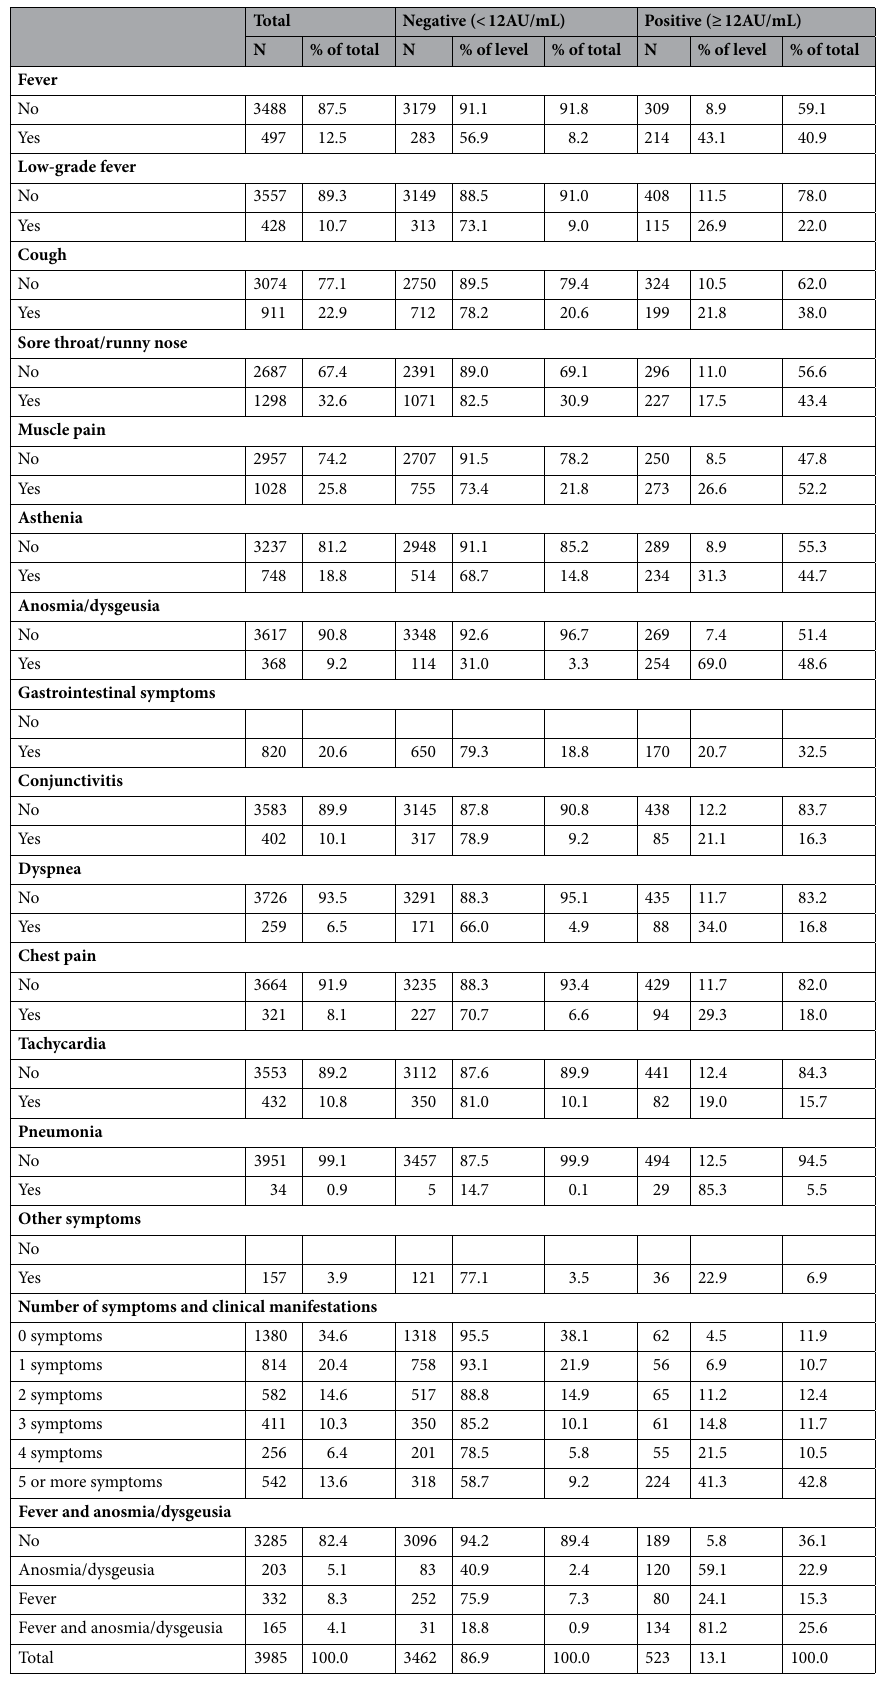
Table 7. Association of symptoms and clinical manifestations with IgG